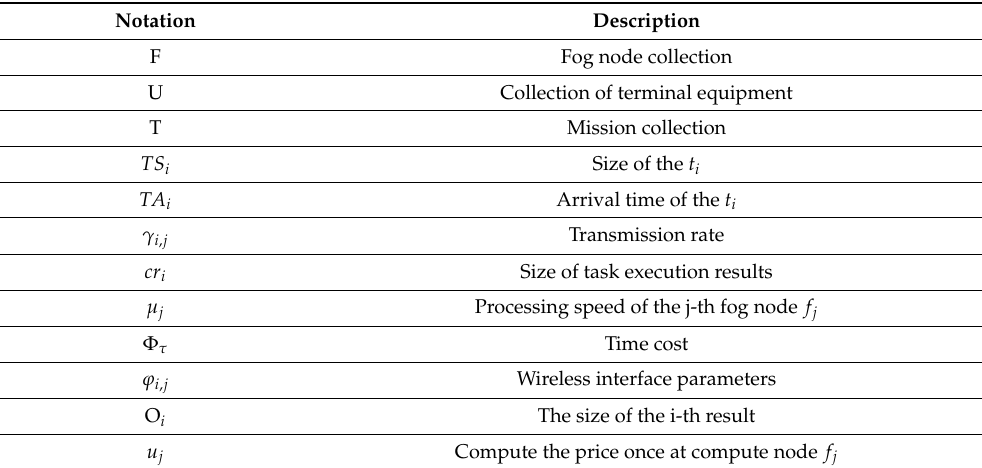
Table 1 explains the notation of the mathematical model. Table 1. Mathematical